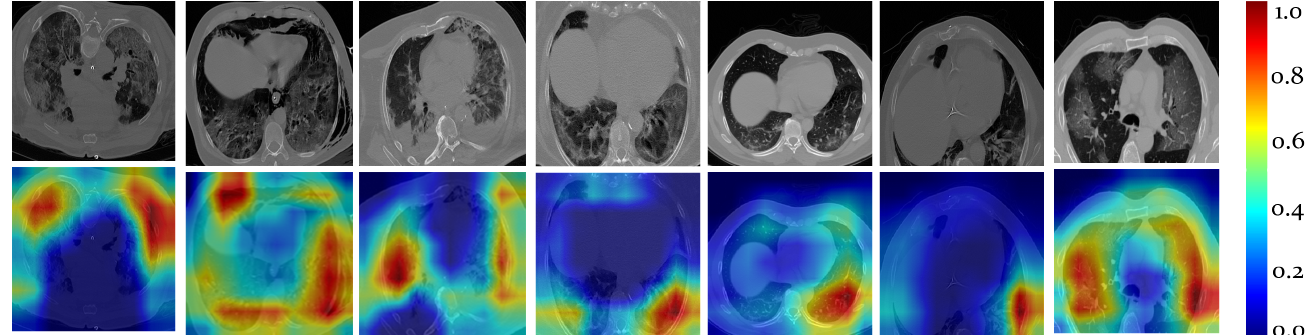
Figure 7. Visualizations of the Gradient Weighted Class Activation map (Grad-CAM) for chest CT slices from seven COVID-19 patients from the test sets. The first four columns correspond to extreme risk while the latter corresponds to severe risk classes. Red and blue regions correspond to maximum and minimum scores for the given class respectively, thus, red to yellow colors represent the most discriminative regions of interest in the corresponding CT images for patient risk assessment. For simplicity, we normalize the scores (i.e., [ 0,1 ]